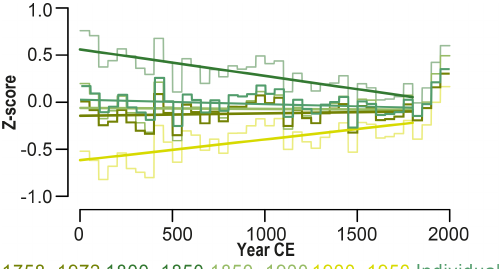
Figure 4. Effect of tree-ring normalization on long-term tempera- ture trends. NH composite tree-ring records from 402 records nor- malized using the means and standard deviations over different time